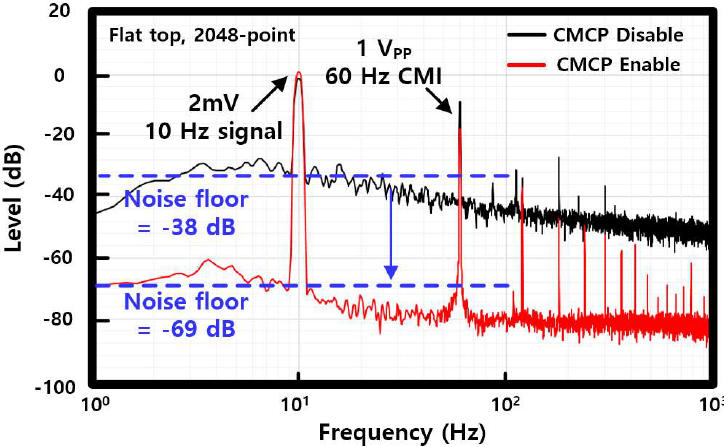
Figure 17. Signal quality measurement result when the CMCP operation is enabled and disabled.